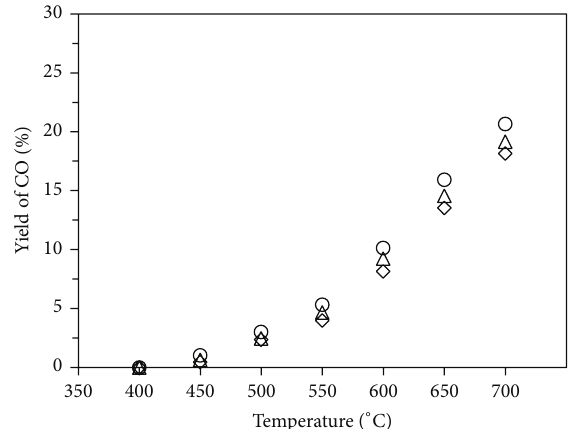
Figure 7: RWGS reaction at 1atm, 𝑃 = 𝑃 = 1 kPa, balance H 2 CO 2 He, GHSV = 282000 h −1 , and 50 mg of catalyst: Cu 80 Ni 20 / 𝛾 -Al 2 O 3 , 10 wt%, where ⃝ = 1st cycle, △ = 2nd cycle, and ⬦ = 3rd cycle.